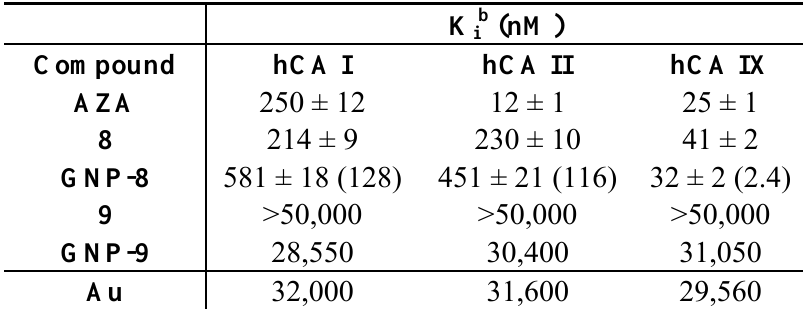
Table 1. CA inhibition data against isoforms CA I, II and IX. a